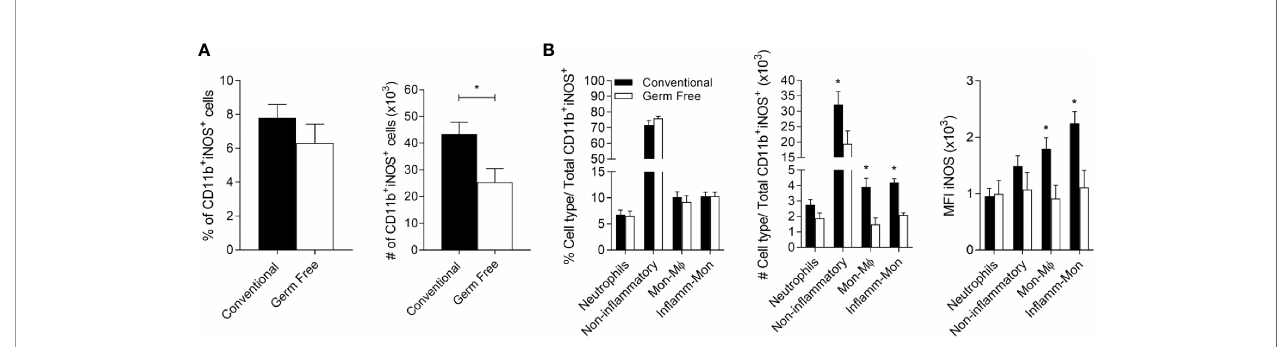
FIGURE 5 | Germ-free mice present fewer microbicidal monocytes/macrophages. (A) Percentage (%) and absolute number (#) of CD11b + iNOS + cells in the footpads of mice six weeks after infection with L. major Wt. (B) Percentage (%) and absolute number (#) of CD11b + iNOS + cells in the footpads of mice 6 weeks after infection. MFI of iNOS + on different populations of CD11b + iNOS + cells in the footpads of mice 6 weeks after infection with L. major Wt. * indicates statistical difference between groups of mice using Student ’ s t test (p < 0.05). Results are representative of two independent experiments. Three to 5 animals were used